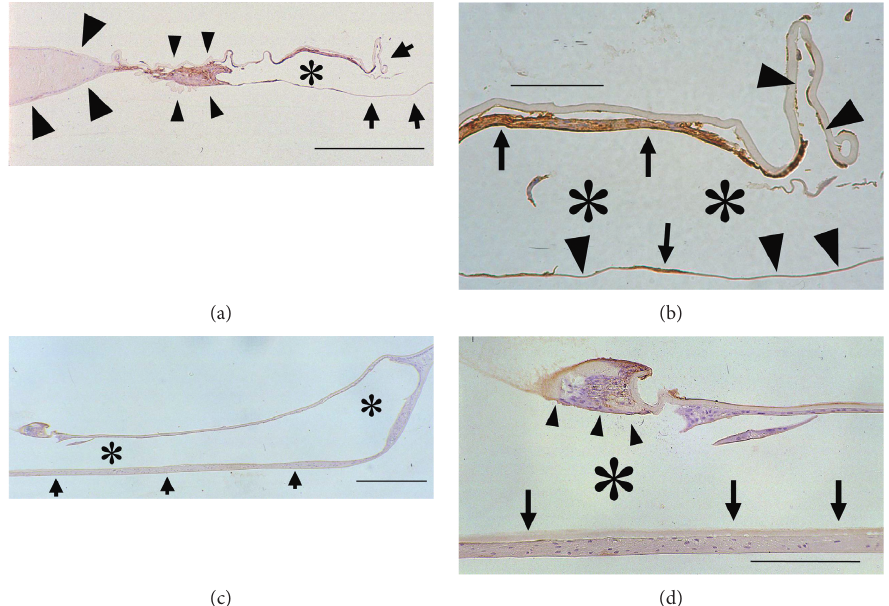
Figure 3: Immunolocalization of α -SMA in pseudophakic rabbit eyes 10 days after cataract surgery. (a) Surrounding type: The flattened and α -SMA-positive LECs cover some parts of the anterior and posterior capsules around the IOL optics. The other parts of the anterior and posterior capsules around the IOL optics have no LECs (arrows). The LECs on the peripheral posterior capsule begin to differentiate and form the Soemmering ring and are negative for α -SMA (large arrowheads), which are separated from the IOL optic by α -SMA-positive LECs around the IOL optic edge (small arrowheads). Bar � 250 μ m. (b) Higher power view of (a): although there are some α -SMA-positive LECs on the anterior and posterior capsules (arrows), LECs are absent from other areas of these capsules (arrowheads). Bar � 50 μ m. (c) Restricted type: the LECs on the posterior capsules begin to differentiate into lens fiber cells (arrows). Bar � 400 μ m. (d) Higner power view of (b): the margin of the anterior capsule is covered with α -SMA-positive, flattened LECs (arrowheads), whereas LECs on the posterior capsule begin to differentiate into lens fibers (arrows). Bar � 125 μ m. (a–d) Sections were stained with 3-3’-diaminobenzidine hydrochloride and coun- terstained with hematoxylin. Asterisks indicate the IOL